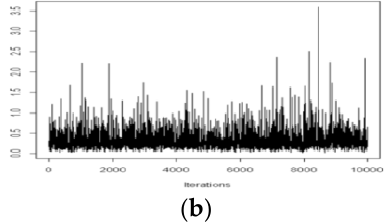
Figure 5. ( a ) Density plot of  and ( b ) trace plot of  (case study). (cid:2868) (cid:2868) Figure 6 shows that the density plot of  (cid:2870) (panel a) is a right-skewed distribution. This potentially occurs since the conditional posterior distribution of  (cid:2870) is the inverse gamma distribution. In addition, the trace plot of  (cid:2870) (panel b) does not show good mix- ing. This suggests that the chains converged slowly.